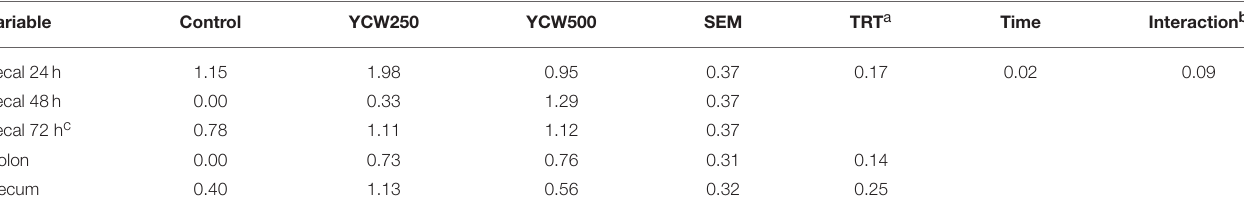
TABLE 6 | Fecal and tissue Salmonella counts (log CFU/g) measured in pigs fed a control (Control) diet or supplemented with a yeast cell wall at 250 mg/kg (YCW250) or 500 mg/kg (YCW500), following administration of an oral Salmonella Typhimurium challenge on d 19.